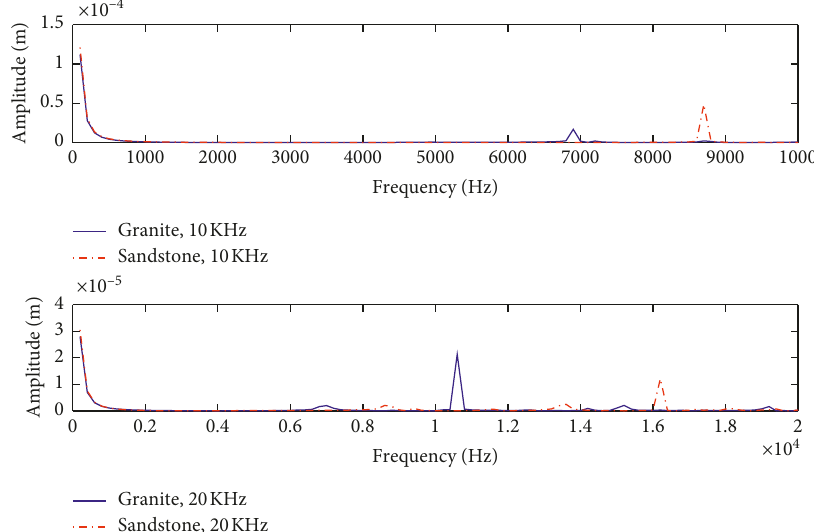
Figure 5: Resonance frequencies of granite and sandstone at different excitation frequencies.